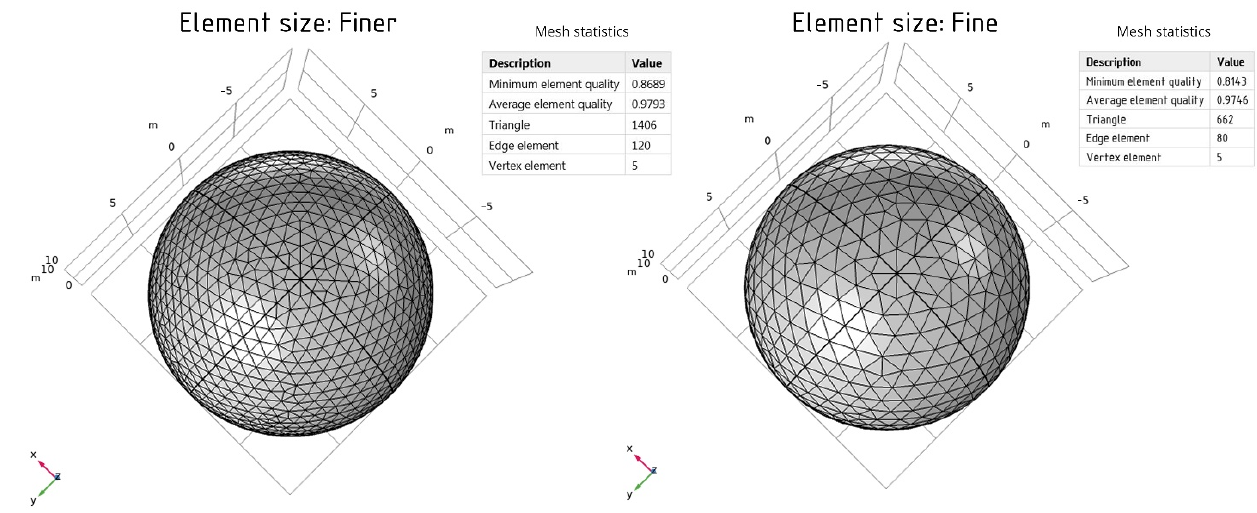
total elastic strain energy is 9020.16 J. Figure 6 represents a graphical diagram showing the maximum and minimum values. Figure 5. The use of two element sizes for the mesh. Figure 5. The use of two element sizes for the mesh.